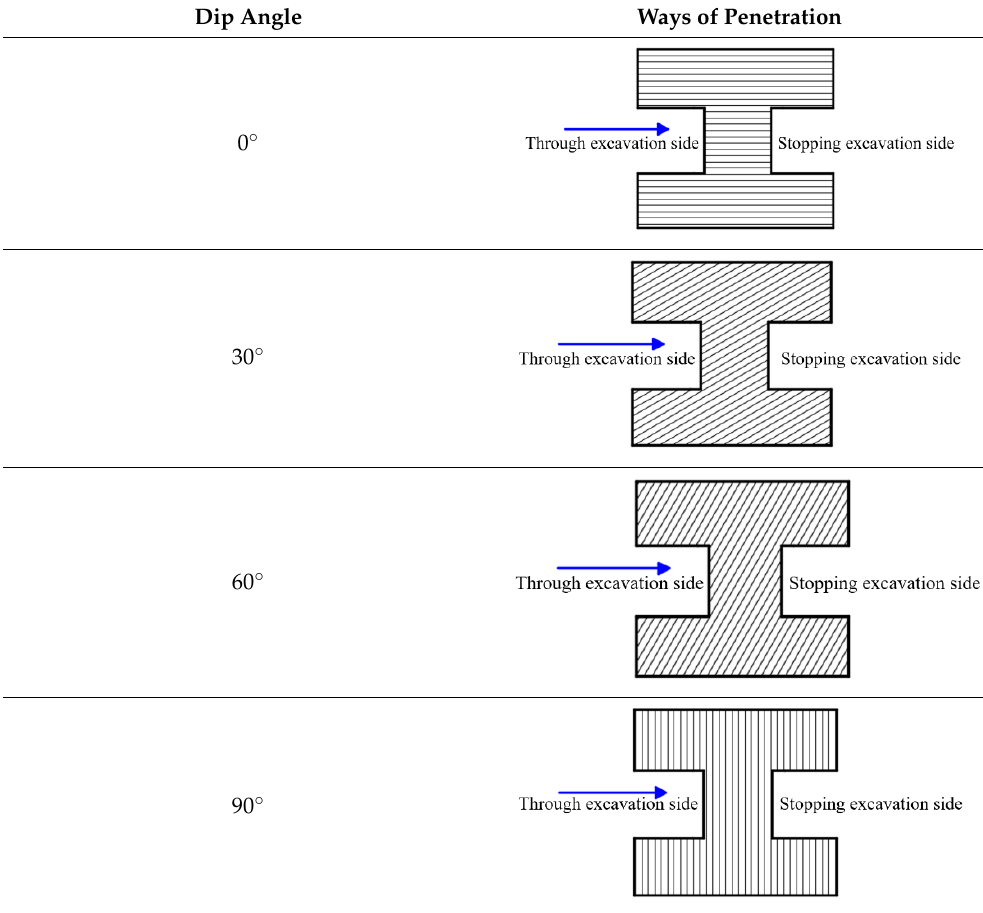
Table 3. Schematic diagram of the tunnel excavation.